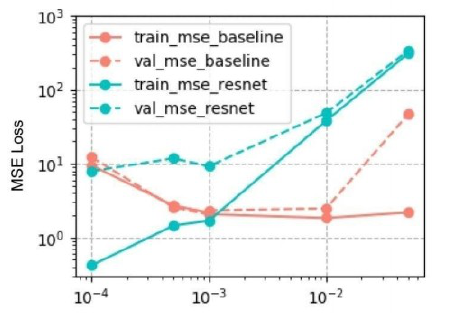
Fig. 4: Initial Learning Rate tuning